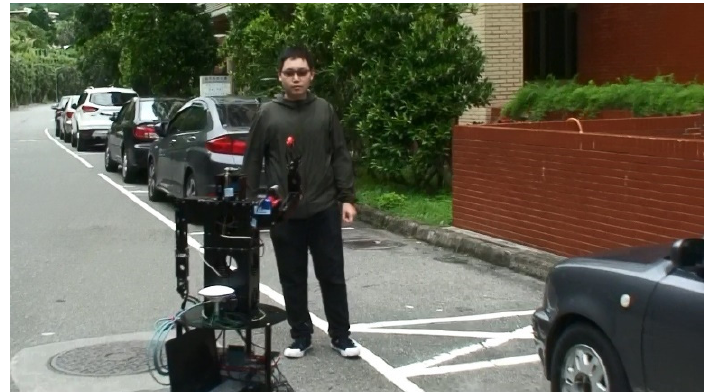
Figure 30. The robot raised hands and gave a loud alarm at the site.